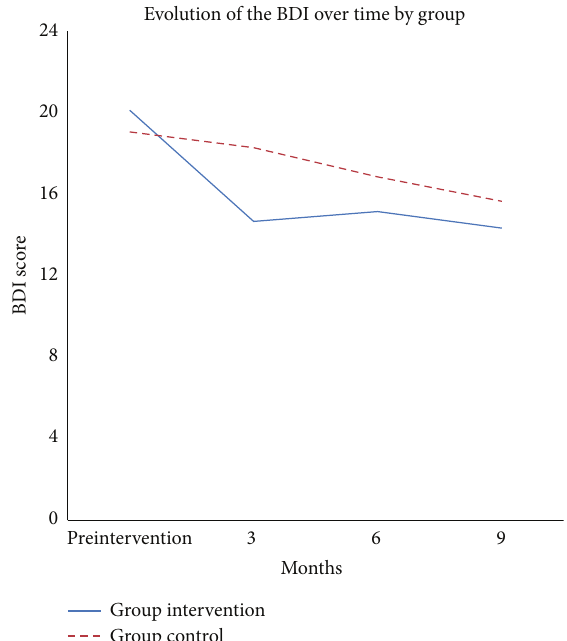
Figure 2: Evolution of the BDI score over time by